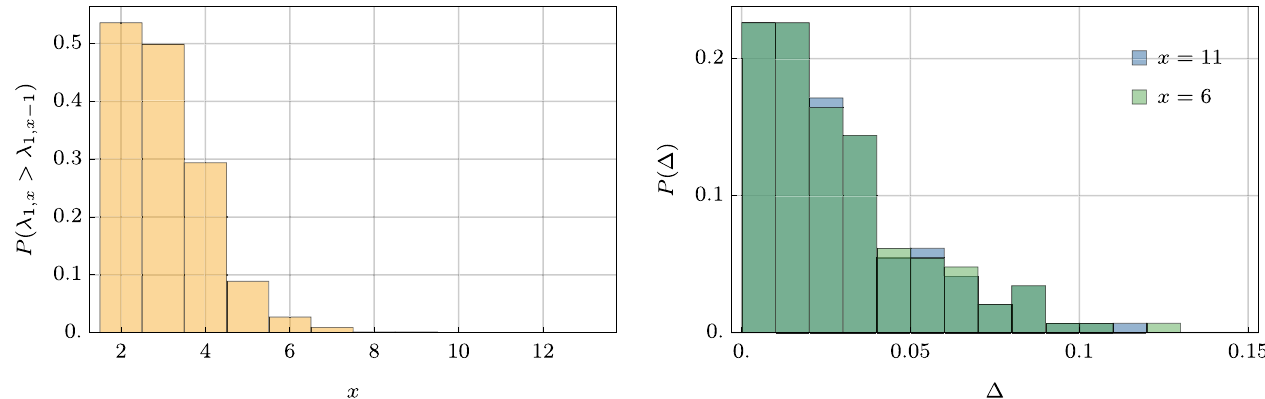
when increasing the size of A ○○ from du ;x du ;x π = 4 ; J 0 . 1 and Haar random 3 ¼ ; 2 ¼